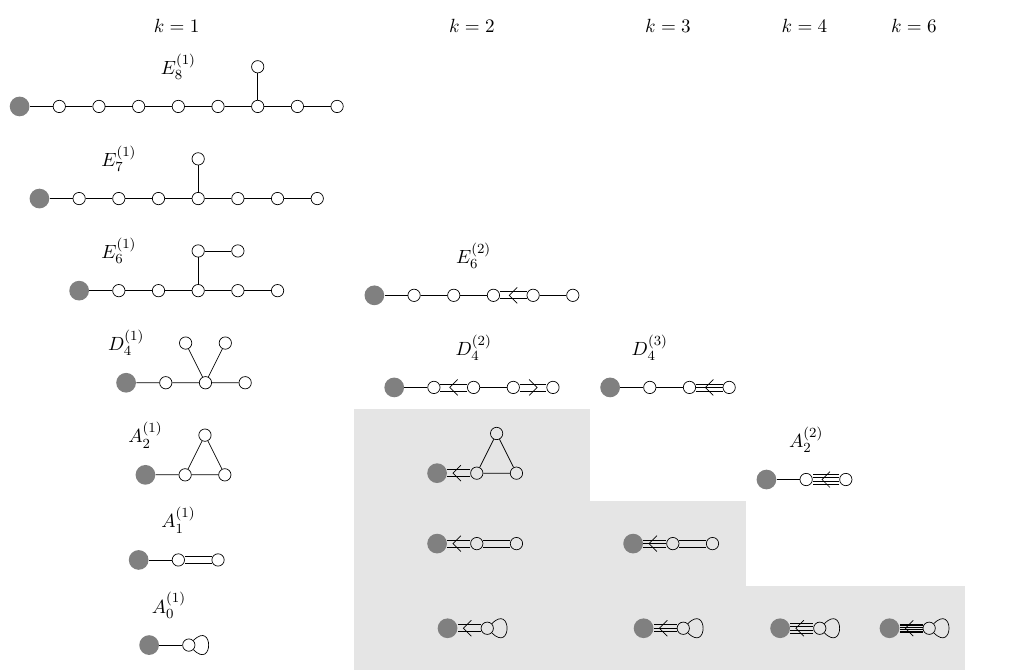
Figure 1 . Patterns that appear in some magnetic quivers of 4d columns labeled by the folding degree k . In all cases, the gray dot represents the rest of the quiver. When labeled (white cells), the white dots form the corresponding (twisted) affine Dynkin diagram. The first column corresponds to the simply laced algebras in the Deligne-Cvitanović sequence. In the gray cells, the Dynkin diagrams are not folded, but the whole diagram becomes long compared to the rest of the